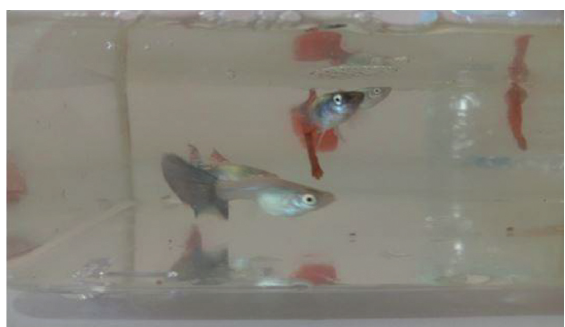
Figure 3: Guppy fish, Poecilia reticulata , toxicity test with Clitoria ternatea .